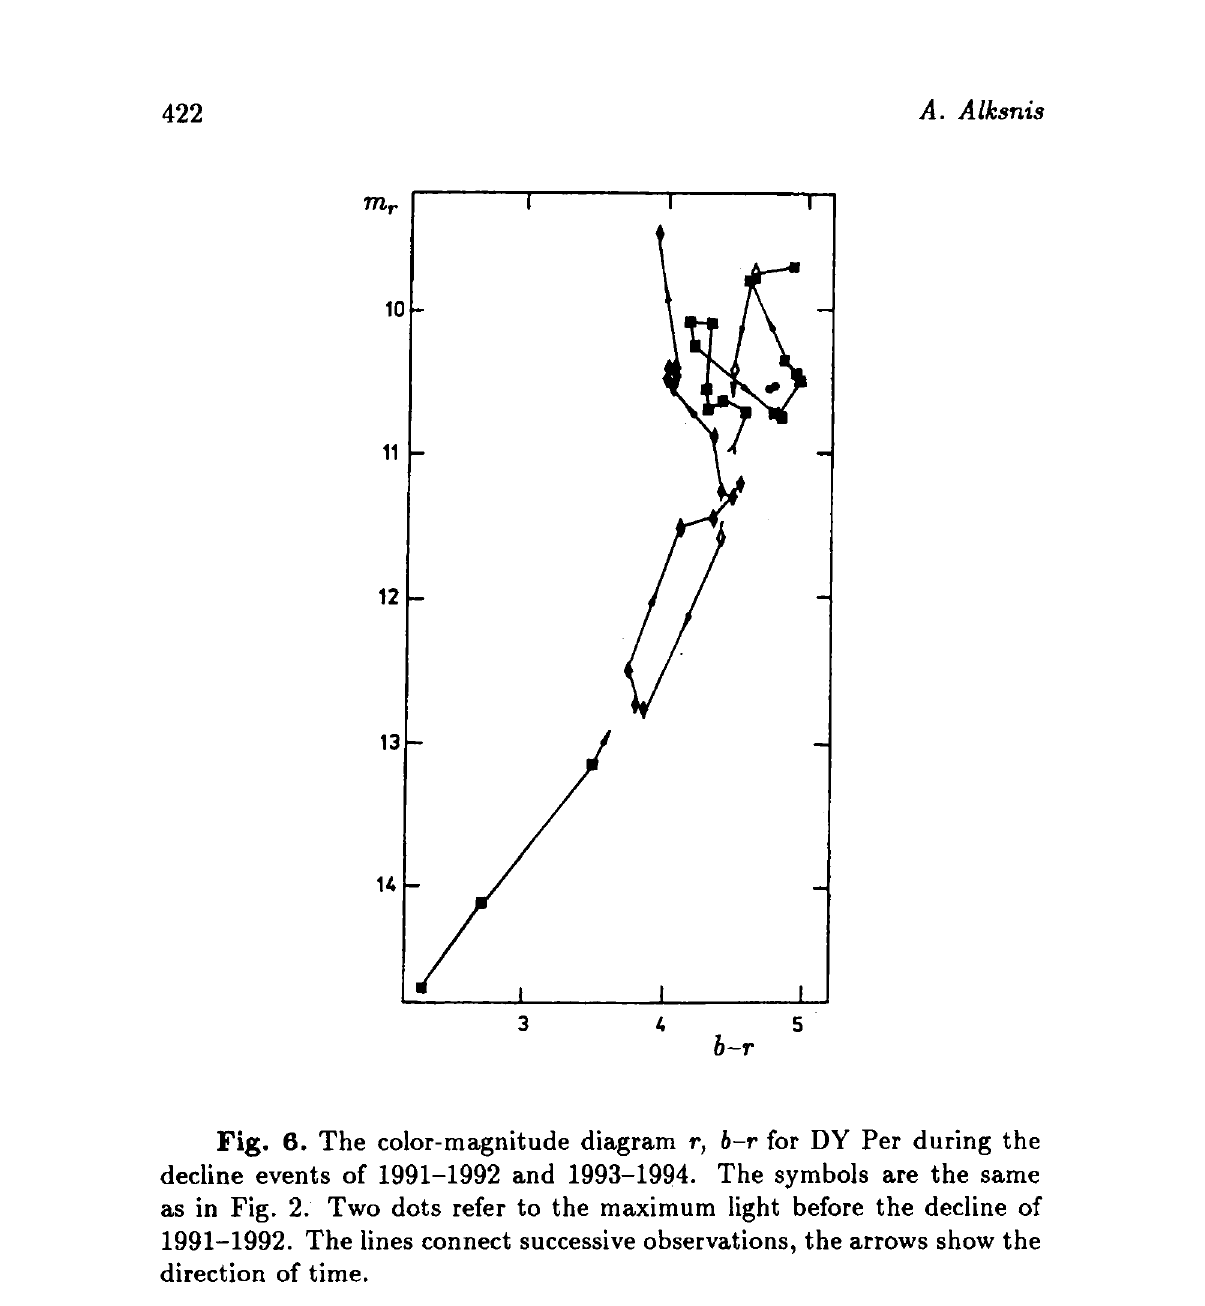
Fig. 6. The color-magnitude diagram r, b-r for DY Per during the decline events of 1991-1992 and 1993-1994. The symbols are the same as in Fig. 2. Two dots refer to the maximum light before the decline of 1991-1992. The lines connect successive observations, the arrows show the direction of